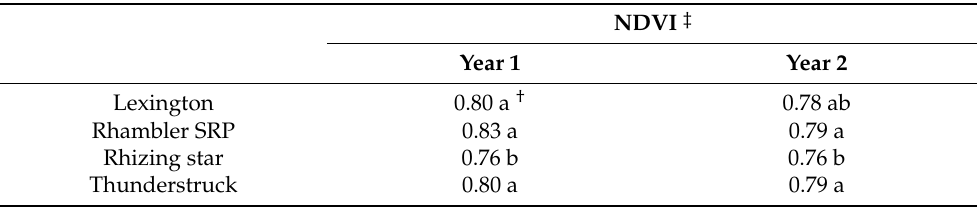
Table 3. NDVI ‡ of four tall fescue cultivars (‘Lexington’, ‘Rhambler SRP’, ‘Rhizing star’, and ‘Thunderstruck’) during the two year of the trial. Data are averaged over 2 N rates, 12 months and 3 replicates, and represent an average of 72 data